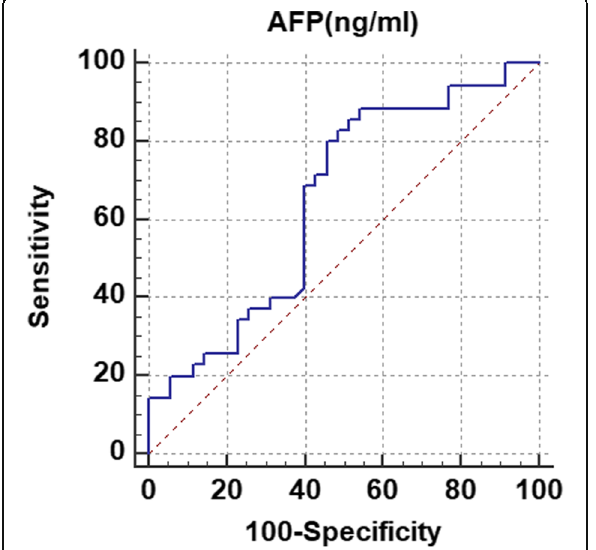
Fig. 2 ROC of AFP in HCC group and cirrhosis